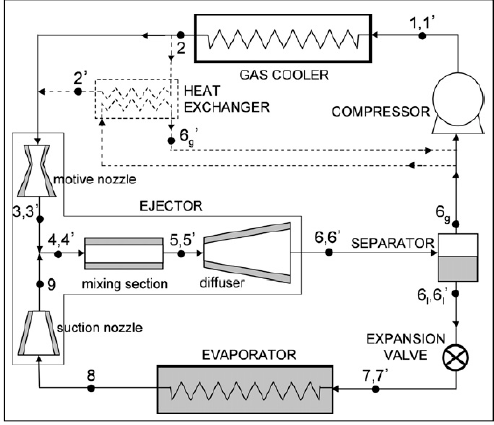
Figure 11. EERC with internal heat recovery [36].